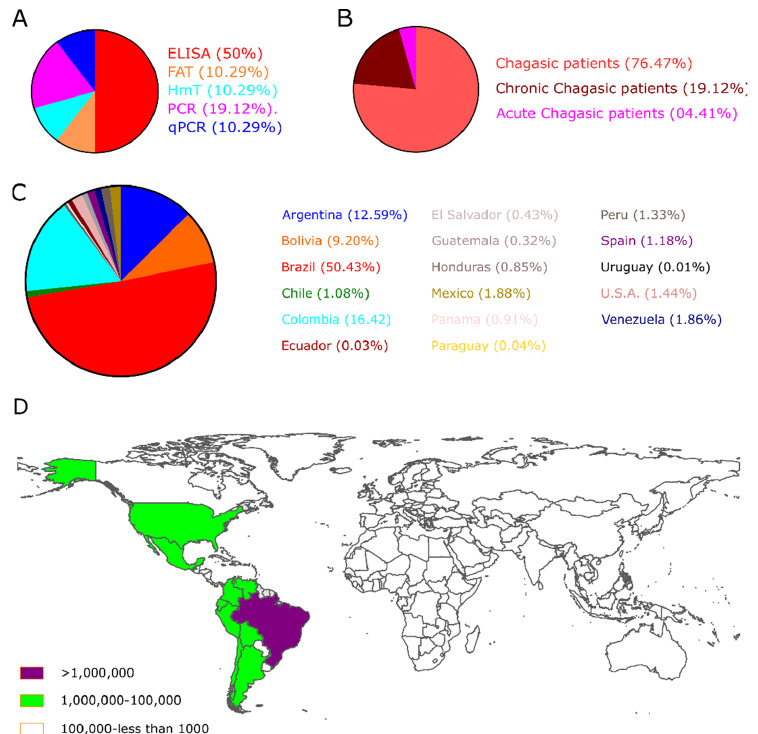
Figure 3. The geographical location of Chagas’s disease studies. ( A ) The pie chart shows the biomarkers; ( B ) the clinical description of patients, and ( C ) the Number of CD patients included in selected studies worldwide. ( D ) Estimative of the global prevalence of Chagas disease, 2017 [8].